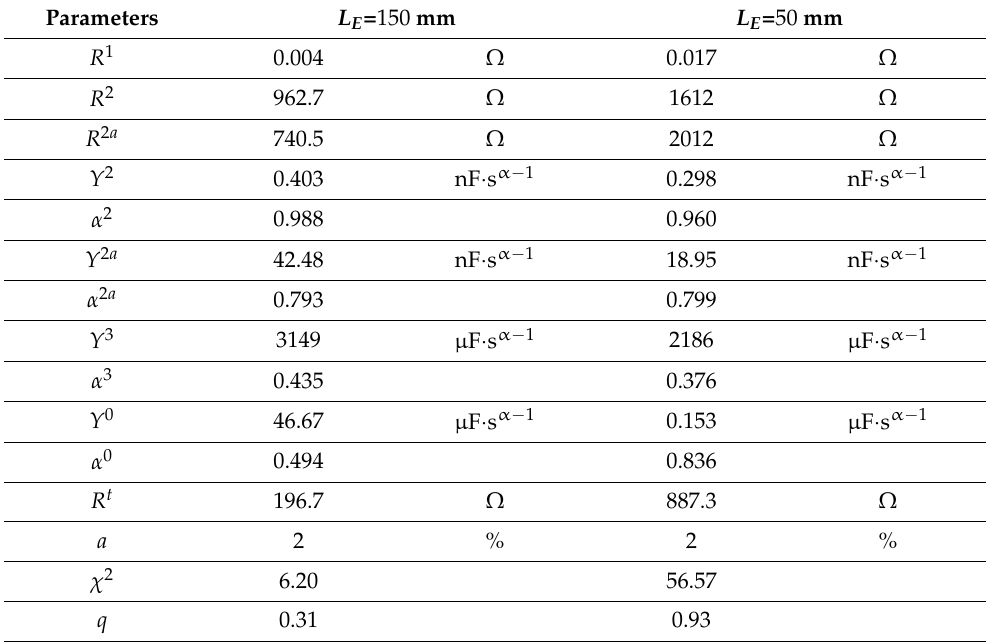
Table A3. Comparison of electrochemical parameters of the electrical equivalent circuit from Figure 7, determined in the first stage of iterative determination of polarization range of reinforcement in concrete for two lengths L E of the rectangular counter